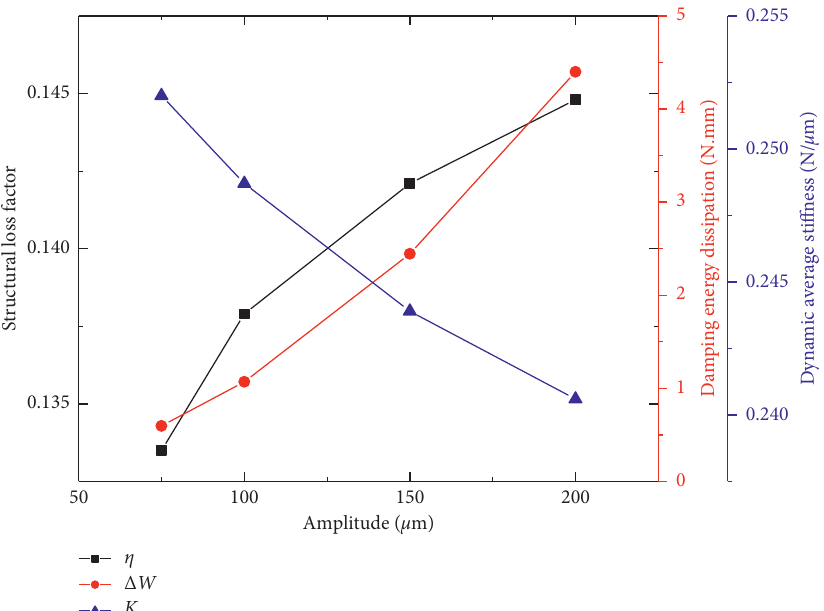
Figure 7: The evolution of damping characteristics under the conditions of group 1 (( f ) � 2